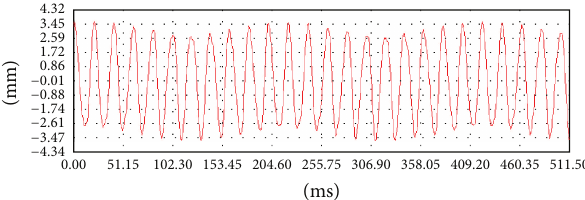
Figure 18: Wingtip’s dynamic response of a controlled SMA com- posite wing when the mean wind velocity 𝑉 = 8 m/s.